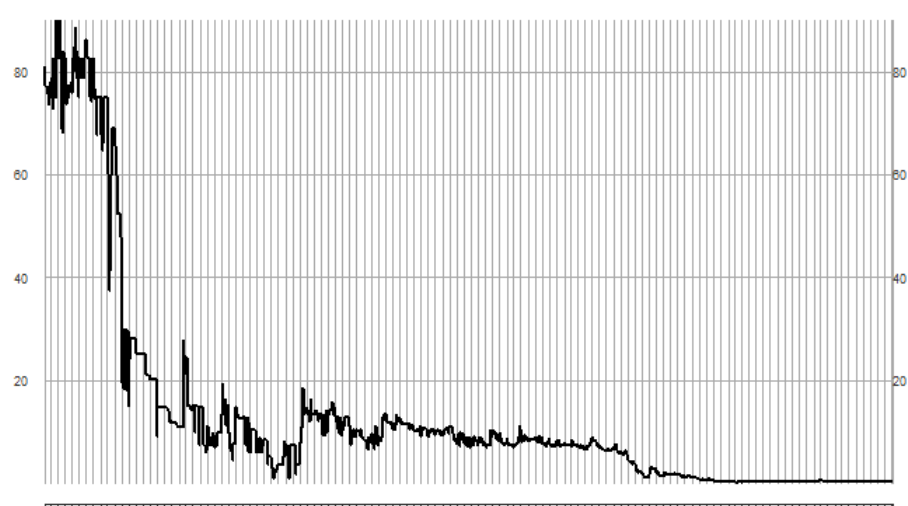
Figure 6. ENRJ closing prices (2008-2017)